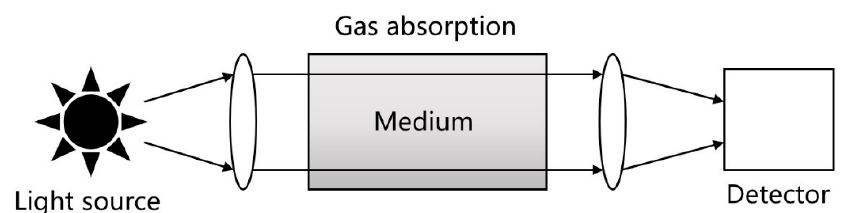
Figure 2. Lambert–Beer law for measuring gas concentration.